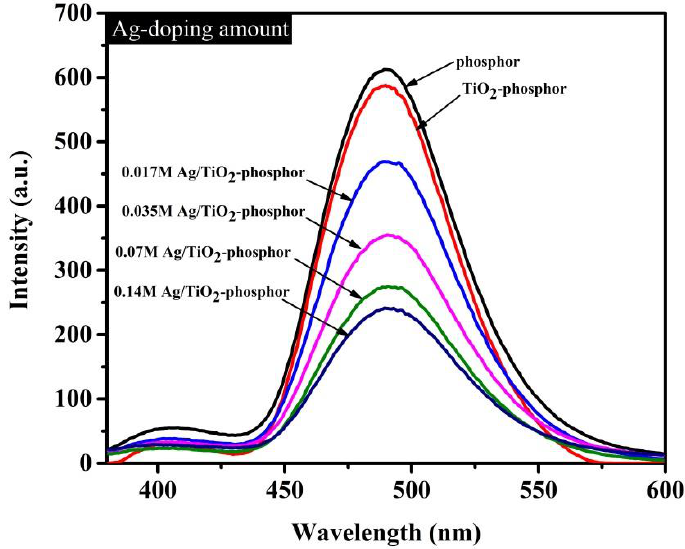
Figure 5. Photoluminescence (PL) emission spectra for TiO 2 /phosphor beads doped with varying Ag content.